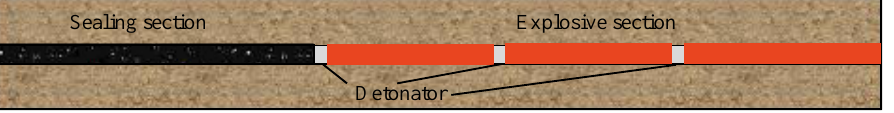
Figure 6. Charging structure.